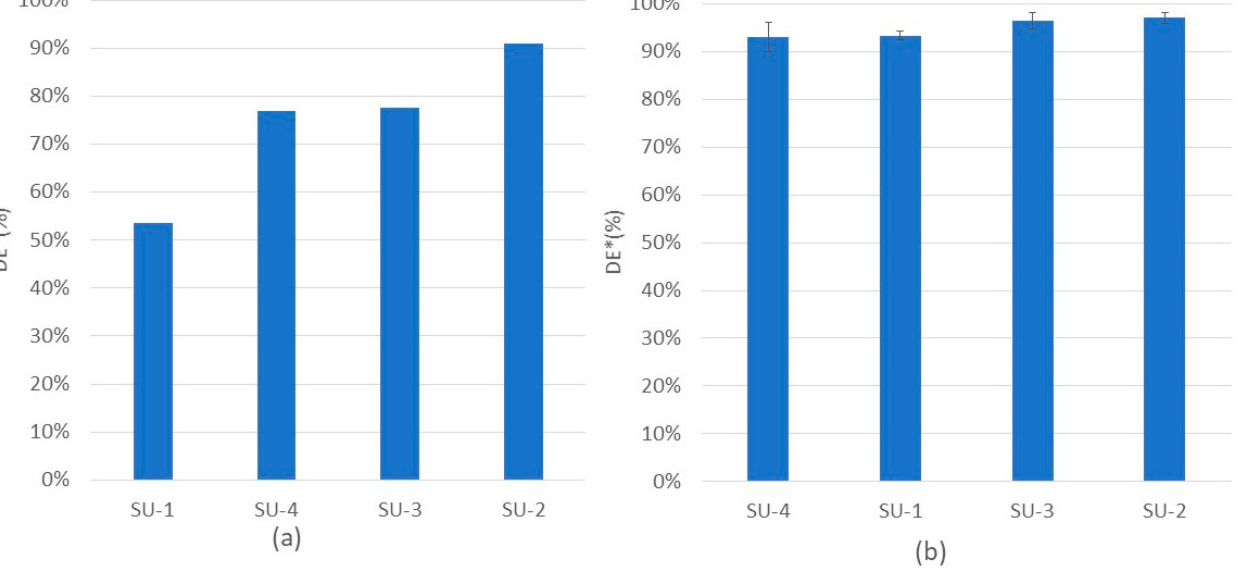
Figure 6. De-inking effect from the scaled-up experiment. ( a ) CIELAB values of the scaled-up samples by measuring the test specimen after extrusion. ( b ) De-inking rate by sorting the un-deinked